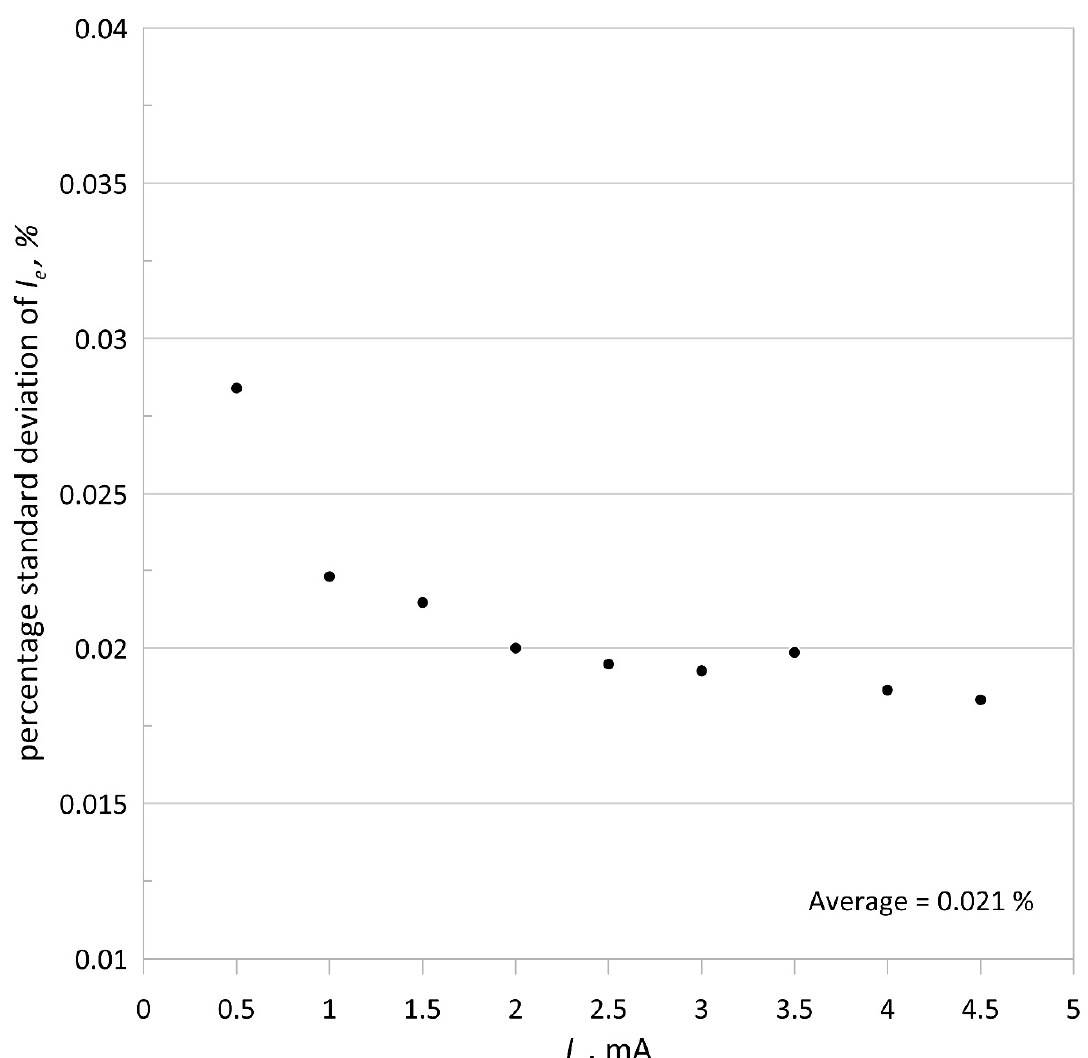
Figure 7. Percentage standard deviation of the emission current versus its intensity.